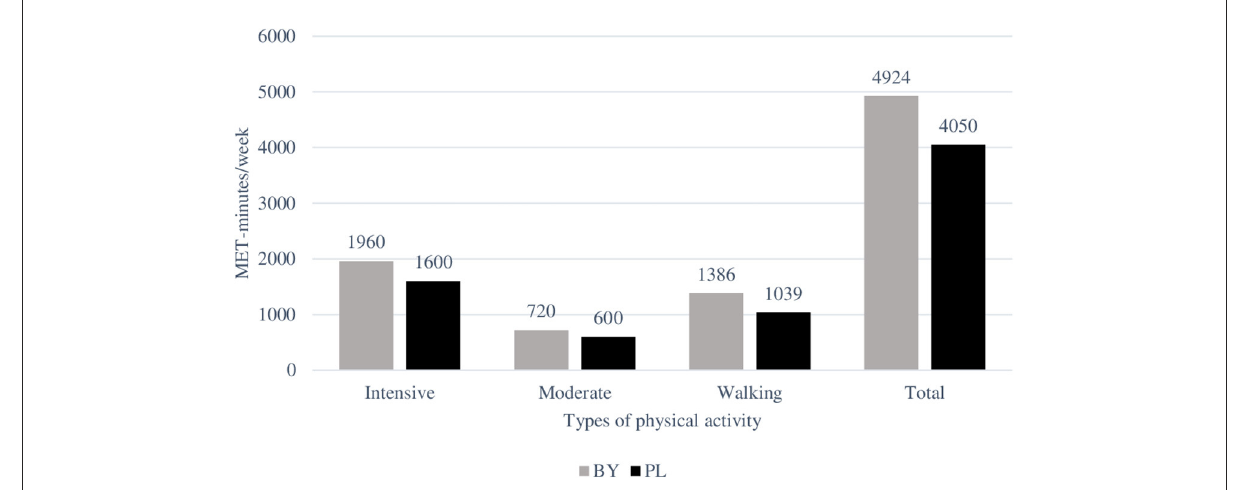
FIGURE1 Proportion of different types of physical activity PA declared by